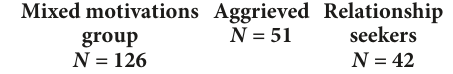
TABLE 7 Associations between threat characteristics and approach. Mixed motivations